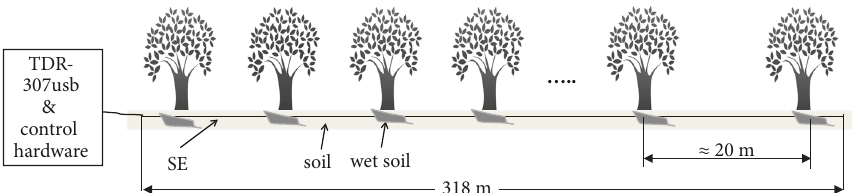
Figure 2: Experiment #1: schematization of the disposition of the SE along the row of trees. The trees were approximately 20 m apart. Dimensions not to